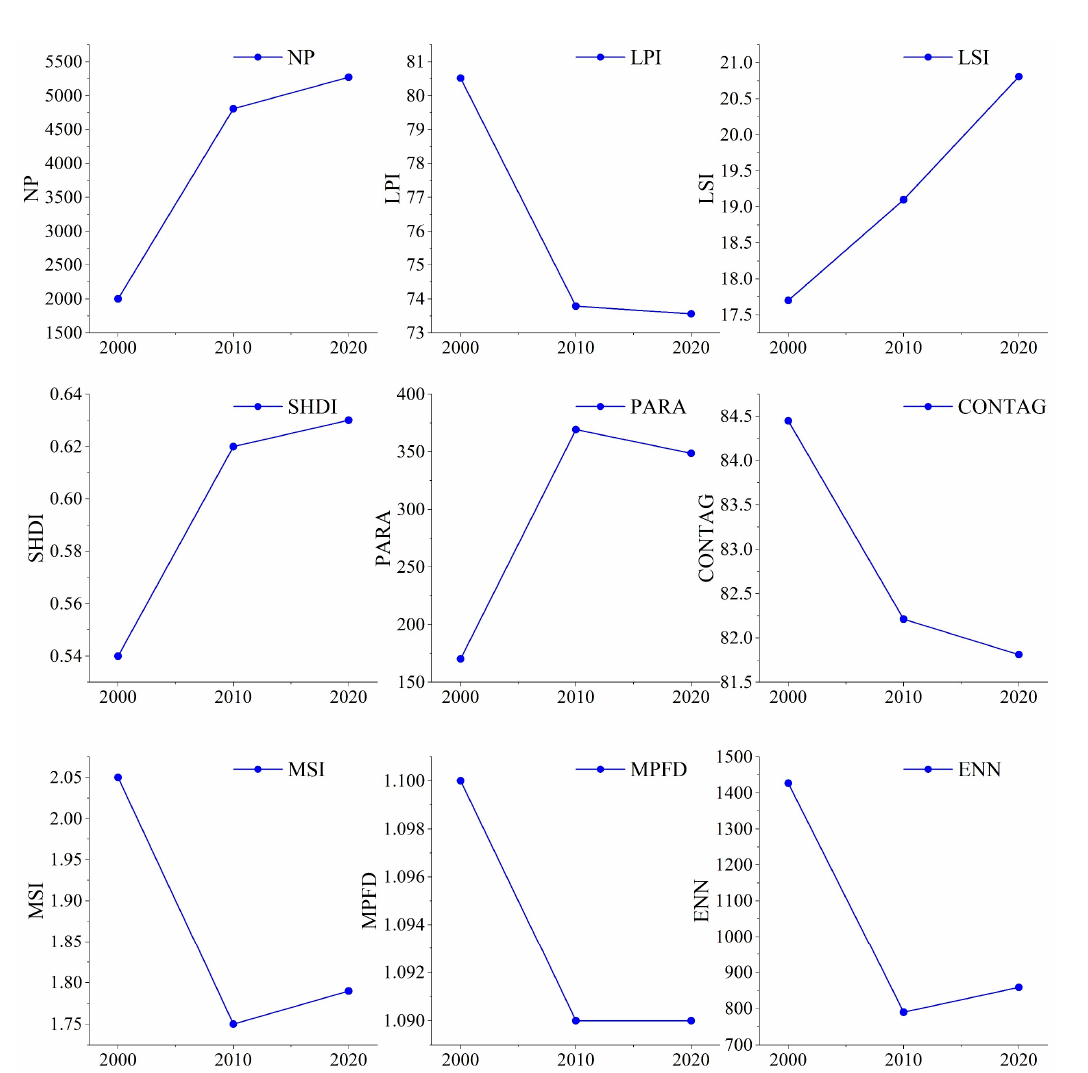
Figure 4. The variation of landscape metrics of the entire study area. NP, LPI, LSI, SHDI, PARA, CONTAG, MSI MPFD and ENN denotes the number of patches, large patch index, landscape shape index, Shannon diversity index, perimeter area ratio, contagion, mean shape index, fractal dimension and Euclidean nearest neighbor, respectively.